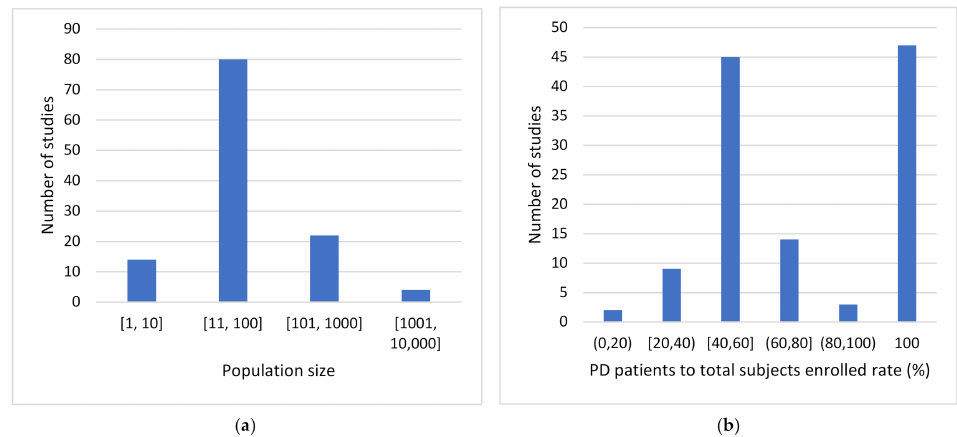
Figure 12. Distribution of the number of the enrolled subjects across the studies considered. ( a ) Total population size across the studies considered in logarithmic scale-based bins. ( b ) The rate of PD patients to total subjects enrolled across the studies considered in 20-width